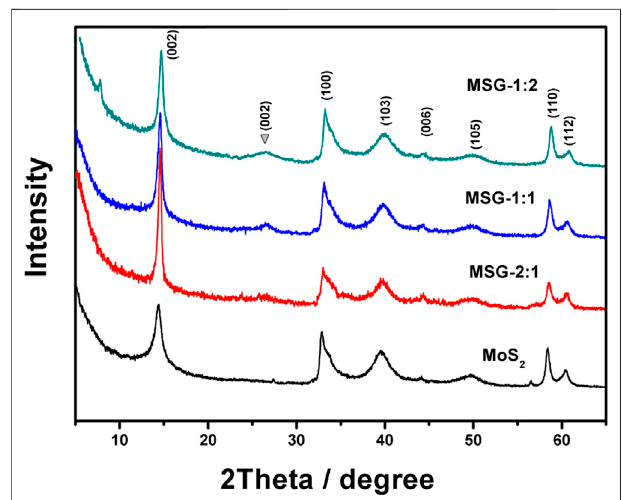
FIGURE 2 | HRTEM image of MSG-1:1.